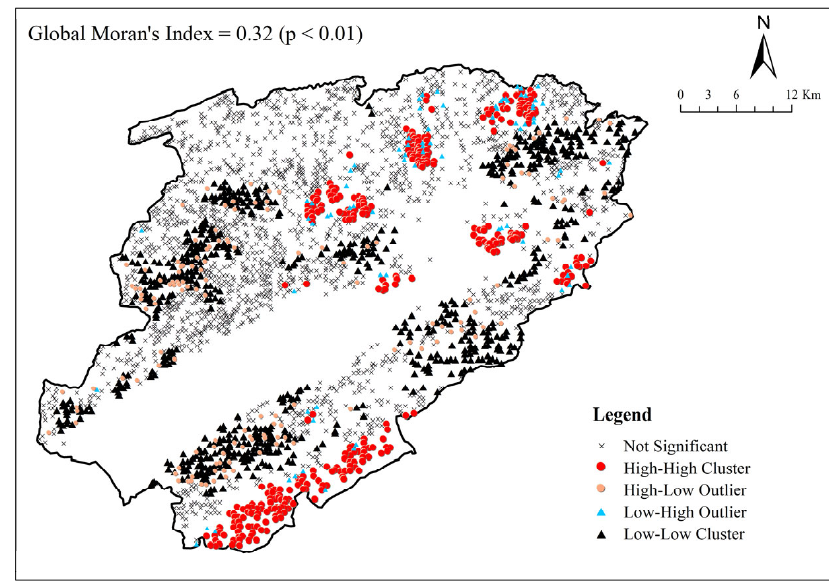
Figure 4. Moran’s index analysis of soil Se content.